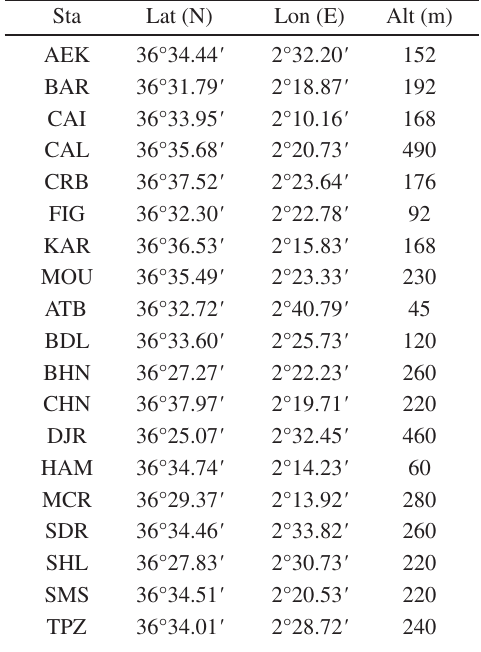
Table III. List of the temporary stations installed to monitor the aftershocks